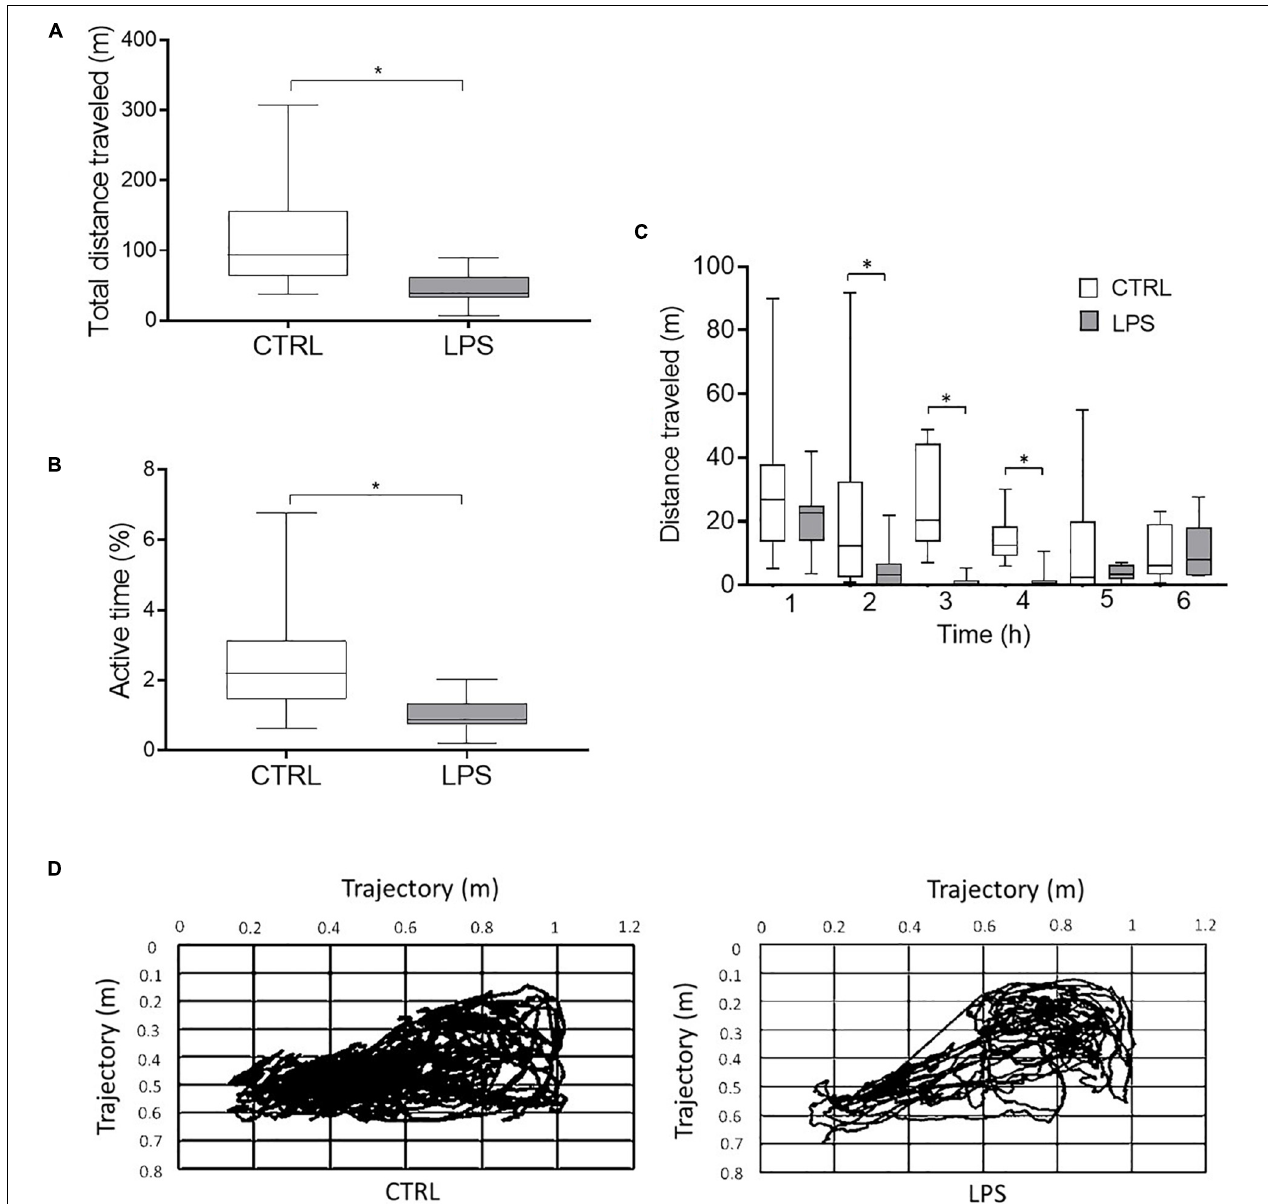
FIGURE 2 | Video analysis of locomotor activity during the 6-h recordings. The total distance traveled (A) and the percentage of time the animal was active (B) were significantly decreased during the LPS compared to the control condition. In addition, the distance traveled per hour of recording (C) was significantly lower at 2, 3, and 4 h after LPS injection. Example of trajectory plots in the control and LPS conditions in one lamb (D) . Results are illustrated as median (Q1, Q3), * p < 0.05 vs. control condition (CTRL).